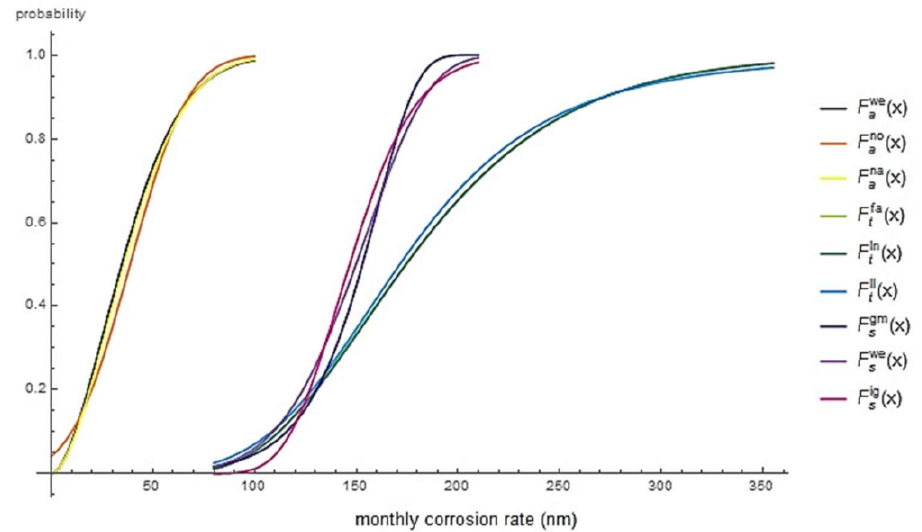
Figure 11. Comparative presentation of CDF graphs for the three best fitted two-parameter distribu- tions for the influence of three different seawater